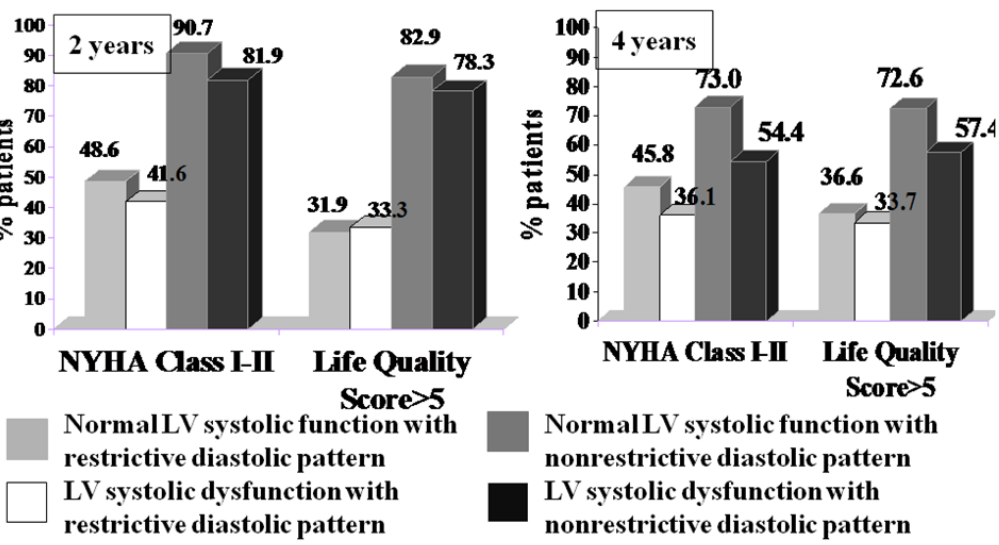
Figure 5. The percentage of patients with a favorable evolution depending on NYHA class and quality of life Score at 2 and 4 years postoperatively after AVR for AR. NYHA—New York Heart Association.